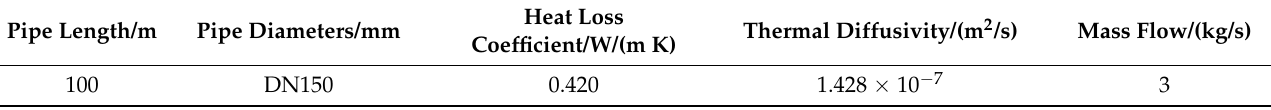
Table 1. Thermodynamic parameters of the heating pipe targeted.